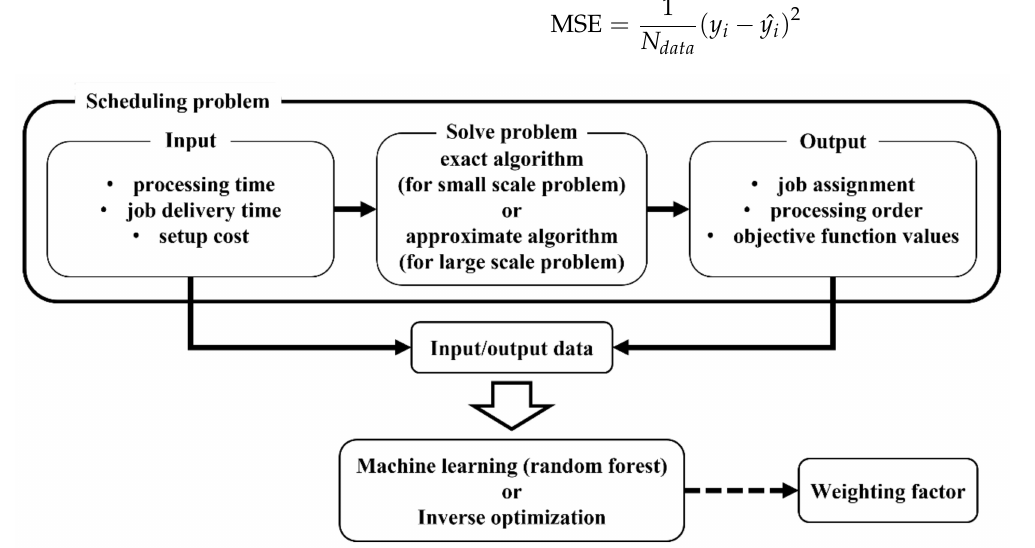
Figure 1. Outline of the weighting factor estimation.